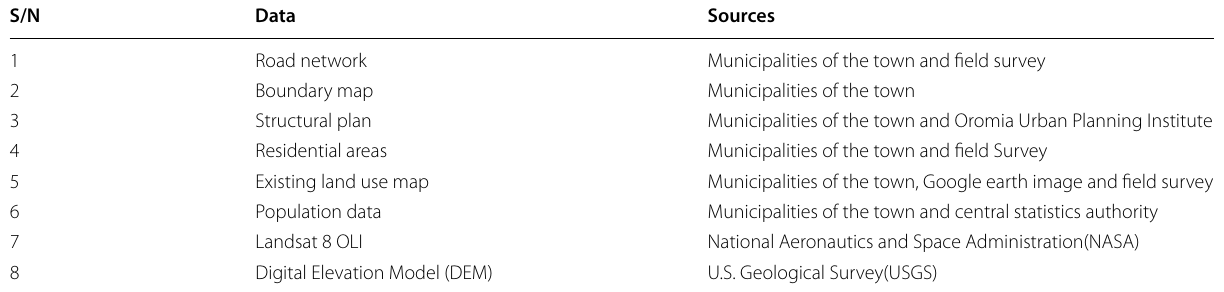
Table 1 List of data and their original sources